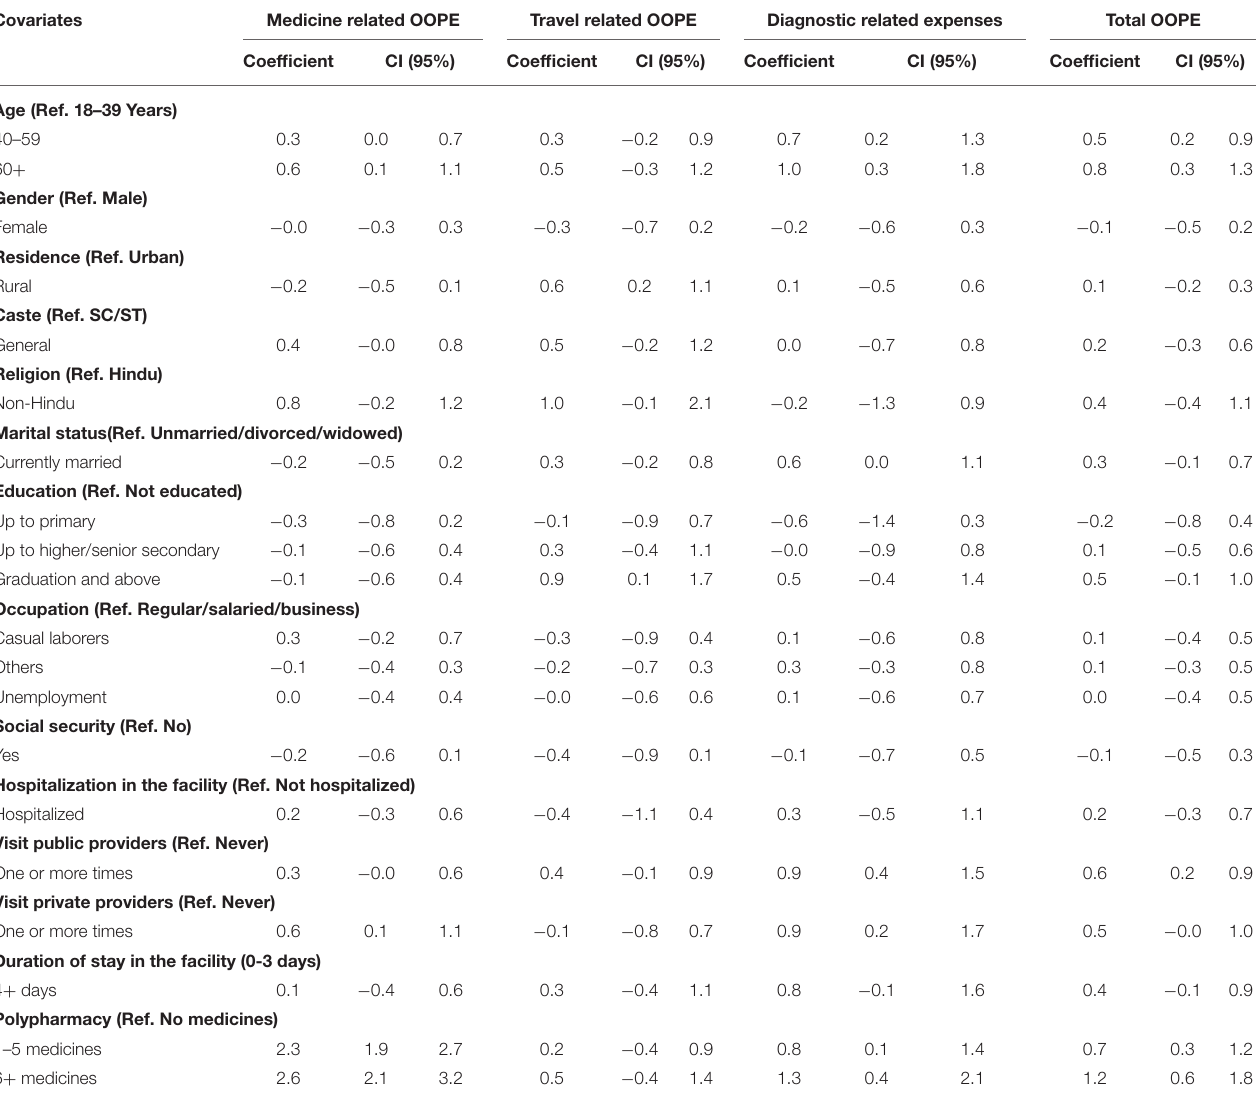
TABLE 7 | Factors influencing Out of pocket expenses in people living with psychiatric conditions. Covariates Medicine related OOPE Travel related OOPE Diagnostic related